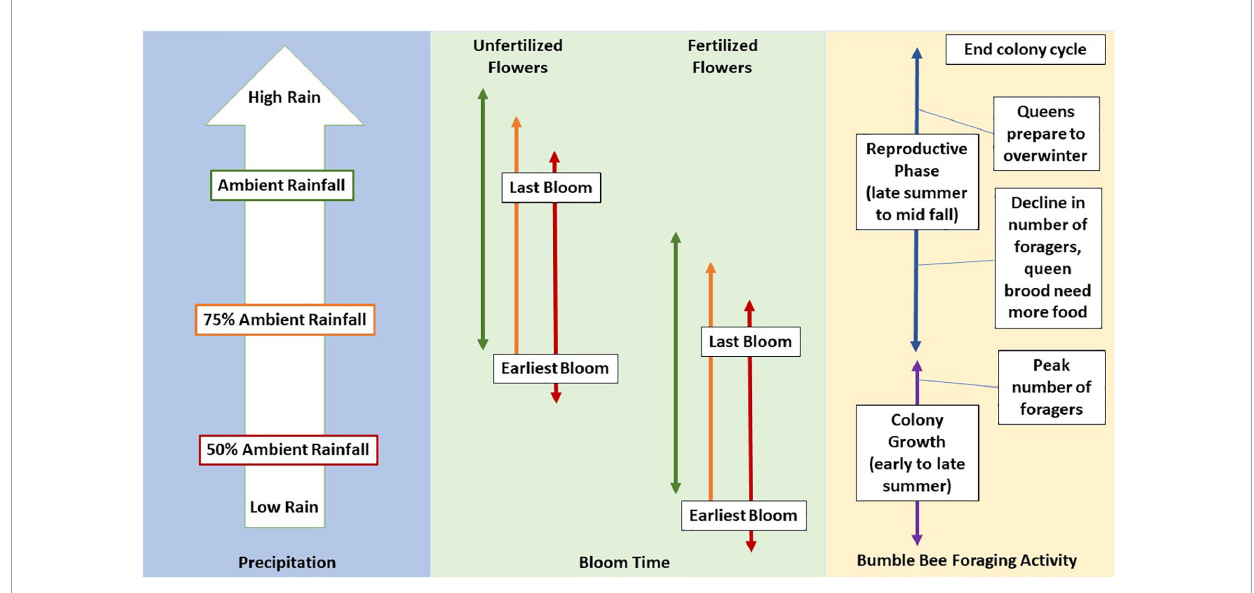
FIGURE1 Predicted effect of fertilizer and drought on phenology. We predict that fertilizer and rain treatments will result in an increase in blooming floral resources earlier in the season and a reduction in resources available to reproductive colonies in the fall. Lines are colored by precipitation and represent time from summer to